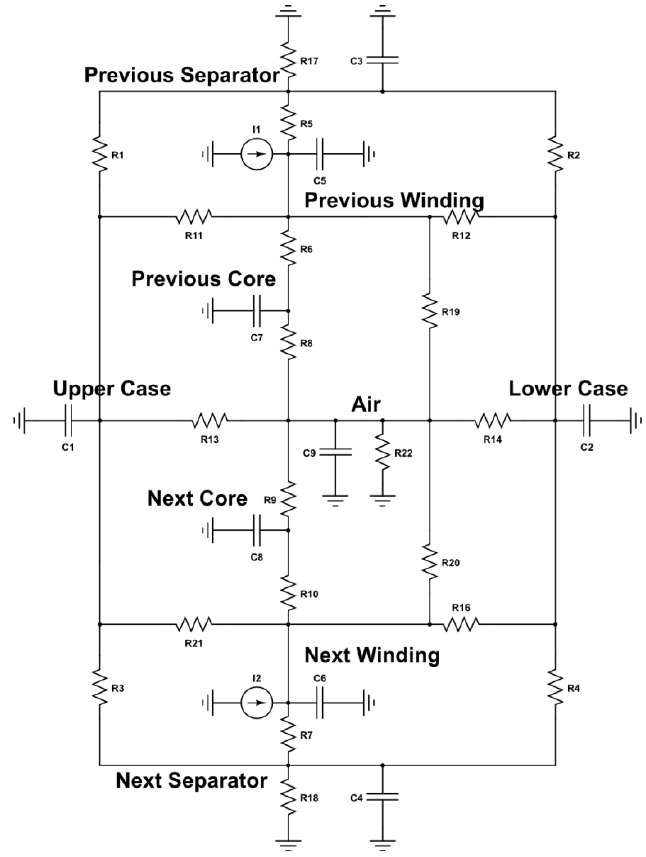
Figure 12. Thermal circuit of the AFSRM.